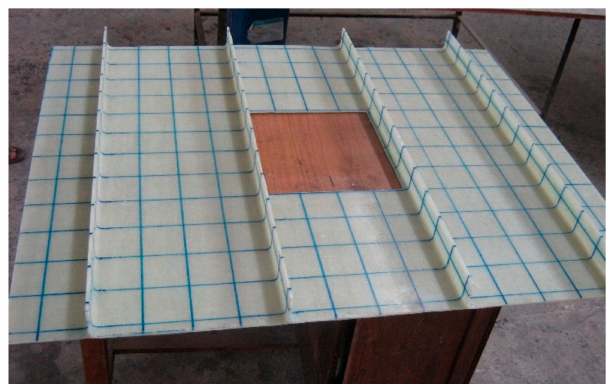
Figure 5. Fabricated GFRP-stiffened composite plate with cutout.